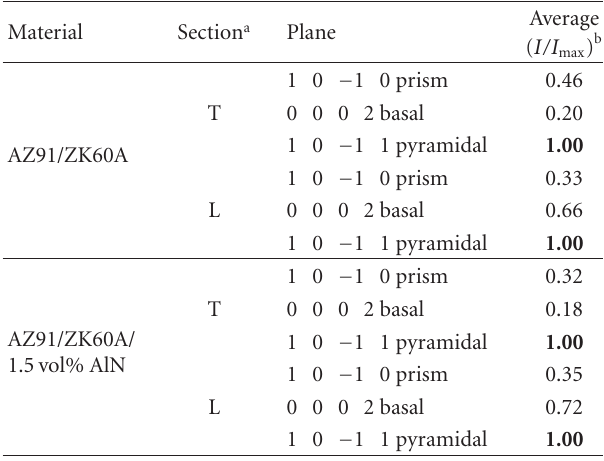
Table 1: Results of grain characteristics and microhardness of Table 2: Texture results of AZ91/ZK60A and AZ91/ZK60A/AlN